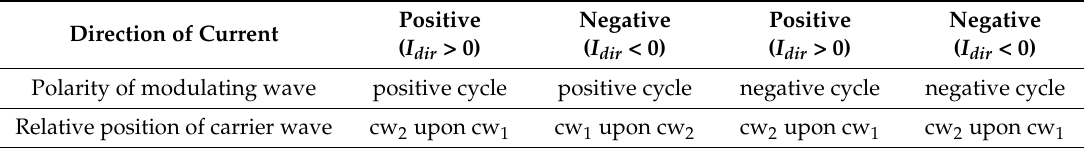
Table 2. Modulation strategy of improved PD-PWM if V dc 1 < V dc 2 .